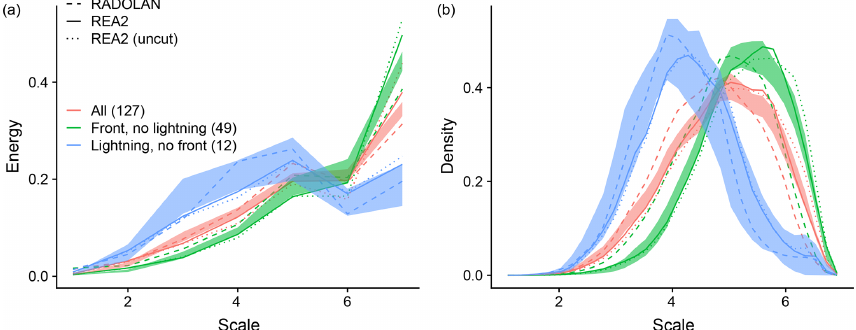
Figure 4. Normalized spatial mean spectra (a) and histograms of central scales (b) , averaged over cases with fronts and no convection (green), convection and no fronts (blue), and all cases (red). Areas indicate the range of these mean curves over the 20 ensemble members. Solid and dashed lines correspond to REA2 and RADOLAN, respectively. The dotted line represents the REA2 spectra obtained without masking the fields with the available RADOLAN data.